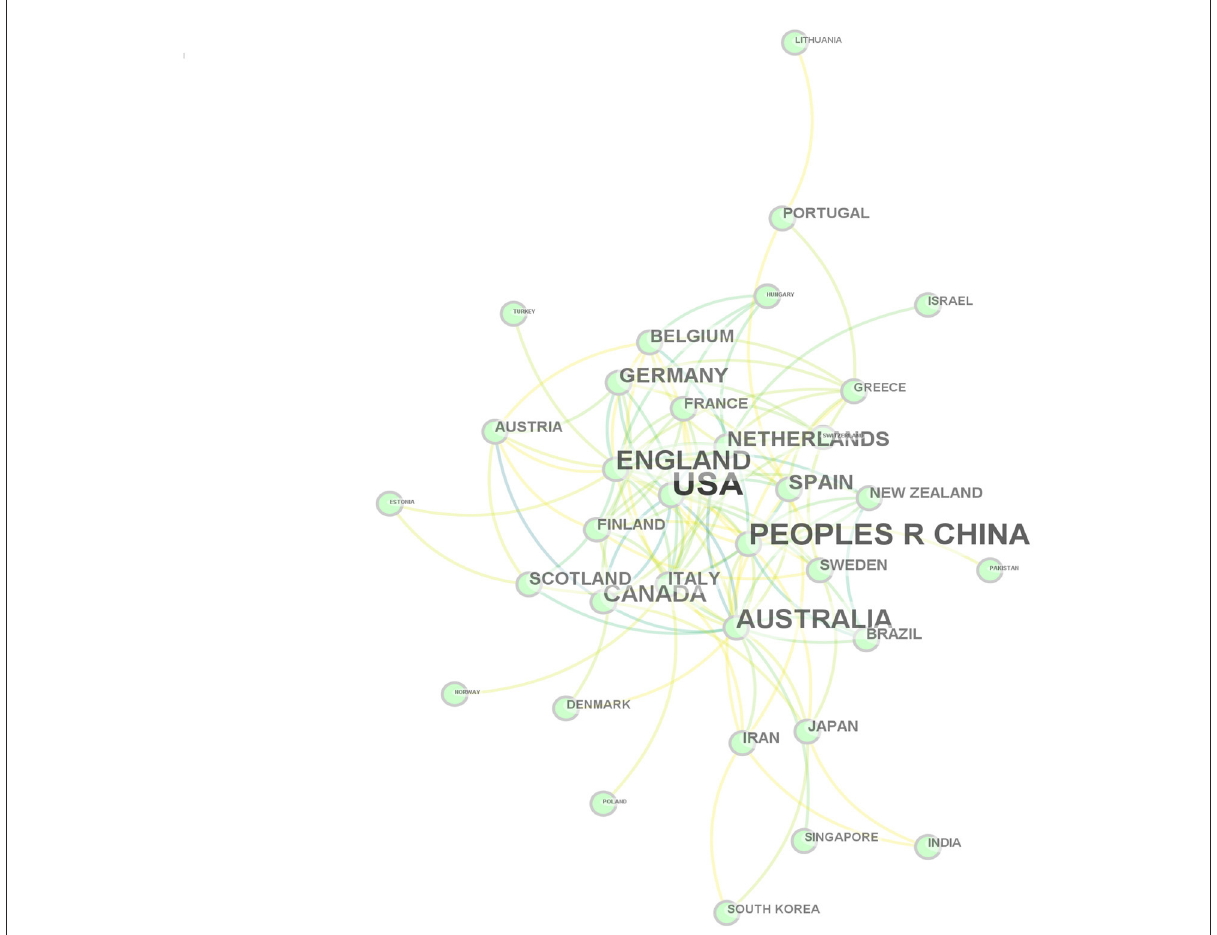
FIGURE3 Countries of origin of